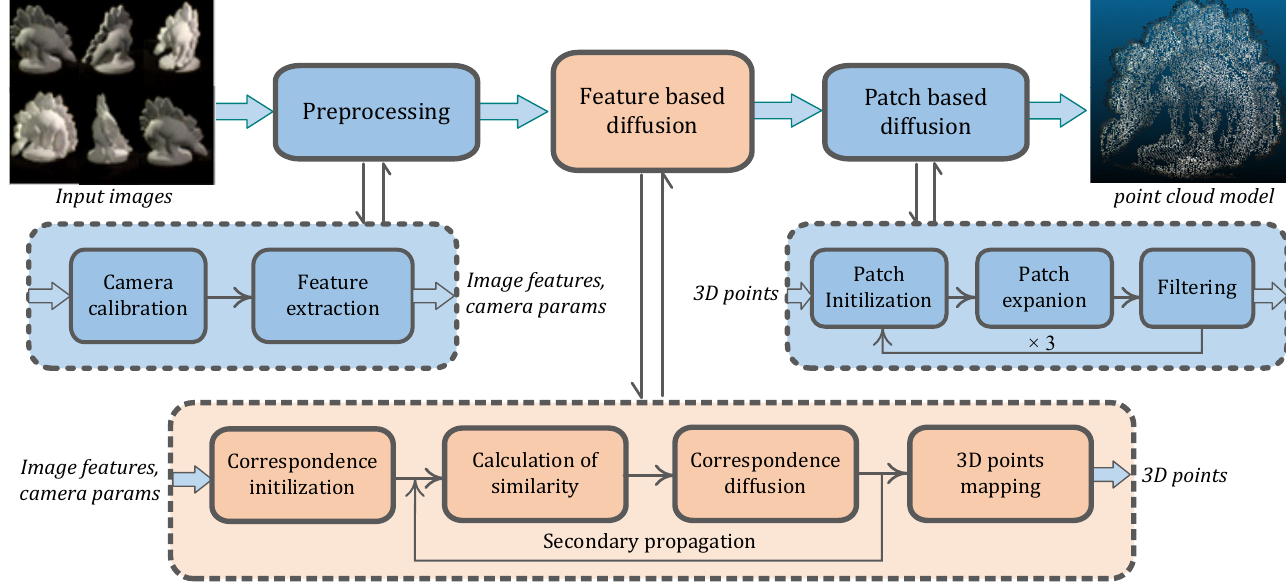
Figure 1. Flow chart of proposed dense reconstruction scheme for image sequence. It takes sequenced images as input and output 3D points via three stages: preprocessing, feature diffusion, and patch diffusion. The dashed boxes unfold the main steps of each stage. Refer to Section 3 for a detailed